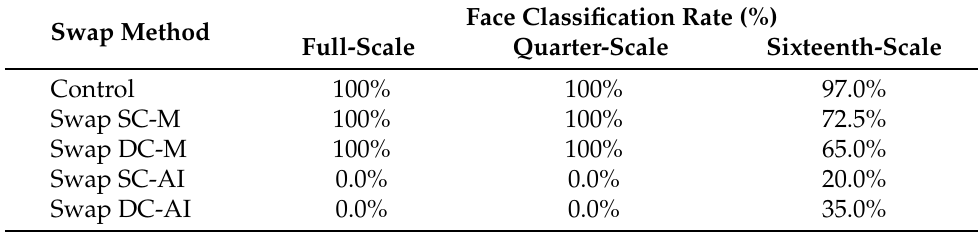
Table A7. Swapped face recognition